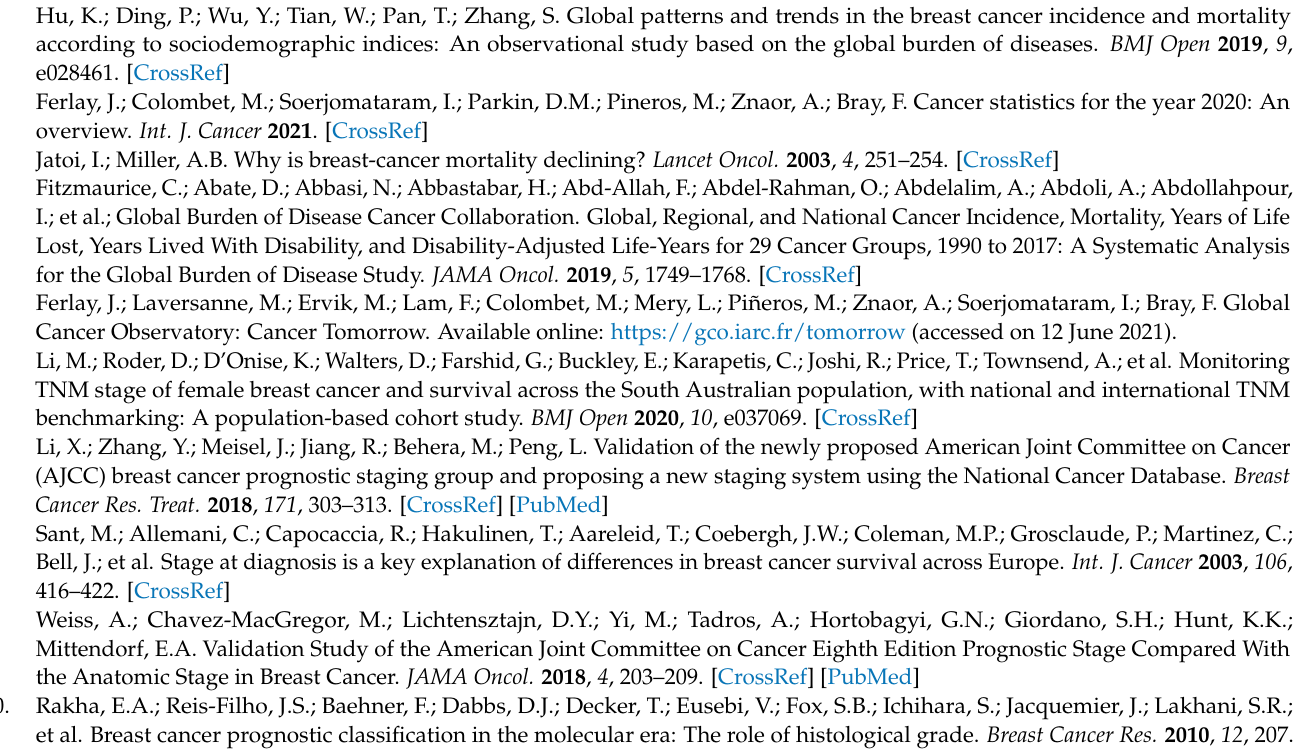
node status, Figure S3: Stratified analyses for finding possible interpretation for heterogeneity in the association between T2DM and ER status, Figure S4: Stratified analyses for finding possible interpretation for heterogeneity in the association between T2DM and PR status, Figure S5: Stratified analyses for finding possible interpretation for heterogeneity in the association between T2DM and Her2 expression, Figure S6: Funnel plots for T2DM and breast tumor characteristics, Table S1: Additional characteristics of studies included in the systematic review and meta-analysis, Table S2: Methodological quality of the included studies based on the QUIPS tool, Table S3: Sensitivity